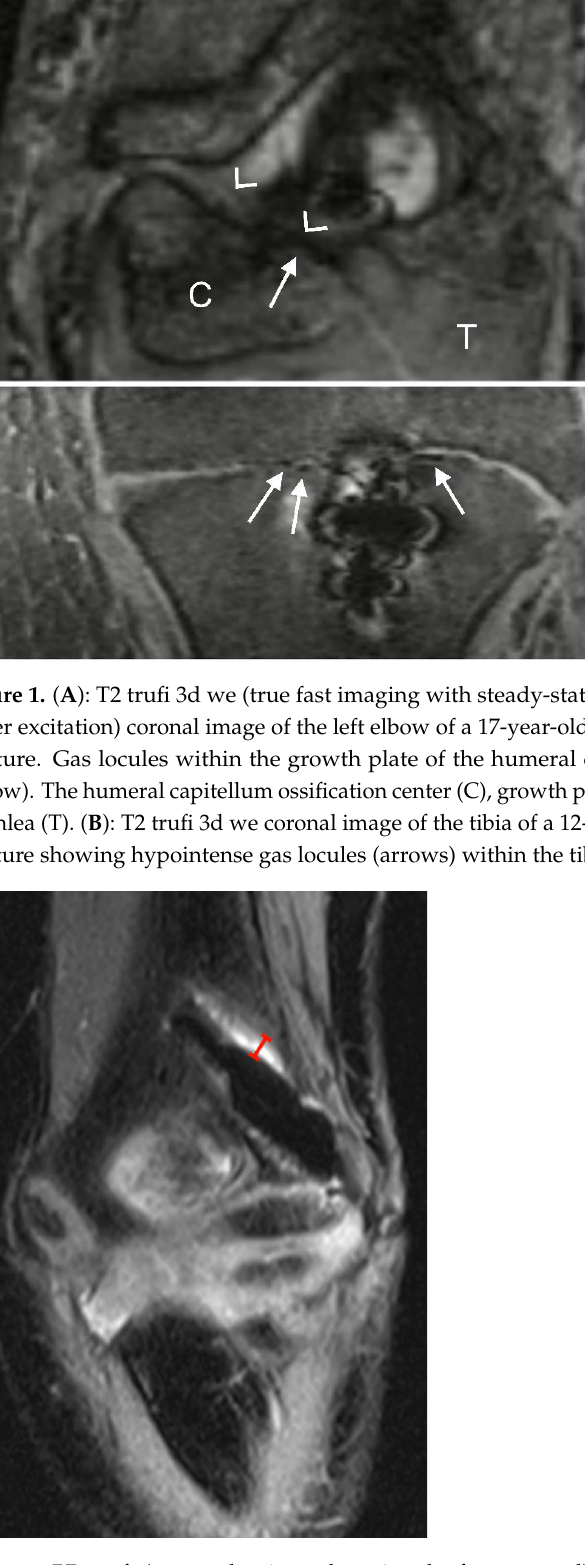
Figure 3. PD tse fs (proton density turbo spin echo fat-saturated) coronal image of the left elbow of a 7-year-old boy with a lateral humeral condyle fracture. Bone marrow edema is seen as a